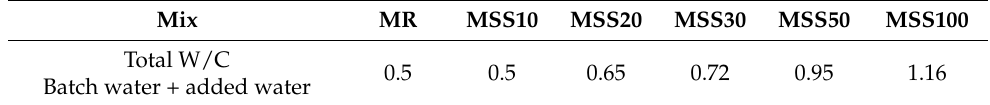
Table 1. Total water amount in prepared mixes.